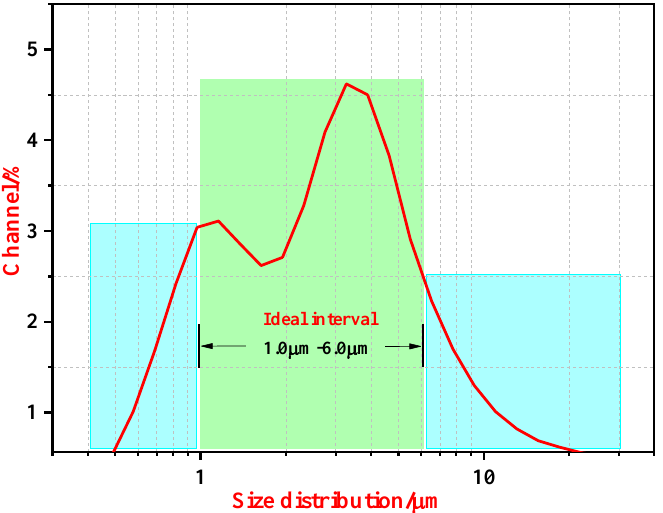
Figure 6. Particle size distribution of PEG 8000-SWNTs dielectric microcapsules.